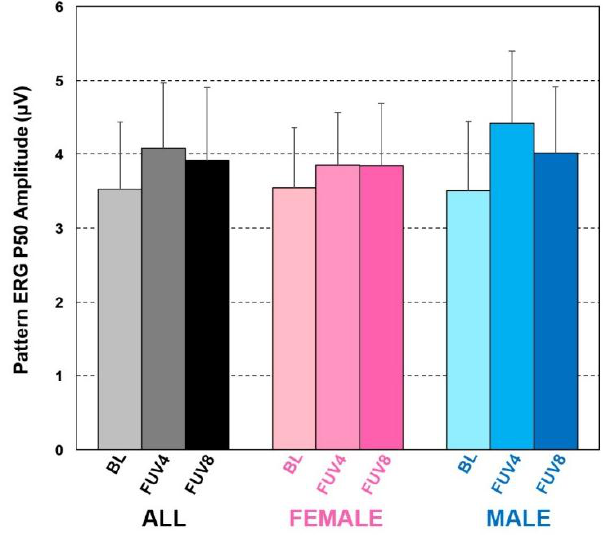
Figure 3. PERG P50 response to 20 mg/day ZX supplementation. Compared to BL, the PERG P50 response increased after supplementation for the whole study sample and in analyses stratified by gender. At FUV4, a 12% average PERG P50 increase was observed ( p = 0.0002), followed only by a partial decline in this improvement after wash-out. Although small, this improvement remained significant vs . BL also at FUV8 ( p = 0.01). The improvement in macular function at FUV4 by PERG P50 criteria was more robust in the male subgroup ( p = 0.0014 at FUV4) than among females ( p = 0.0473 at FUV4). Consistent with the persistent MPOD increases seen at FUV8, also PERG P50 amplitude remained elevated vs . BL at FUV8 in both subgroups, although this difference was no longer statistically significant.